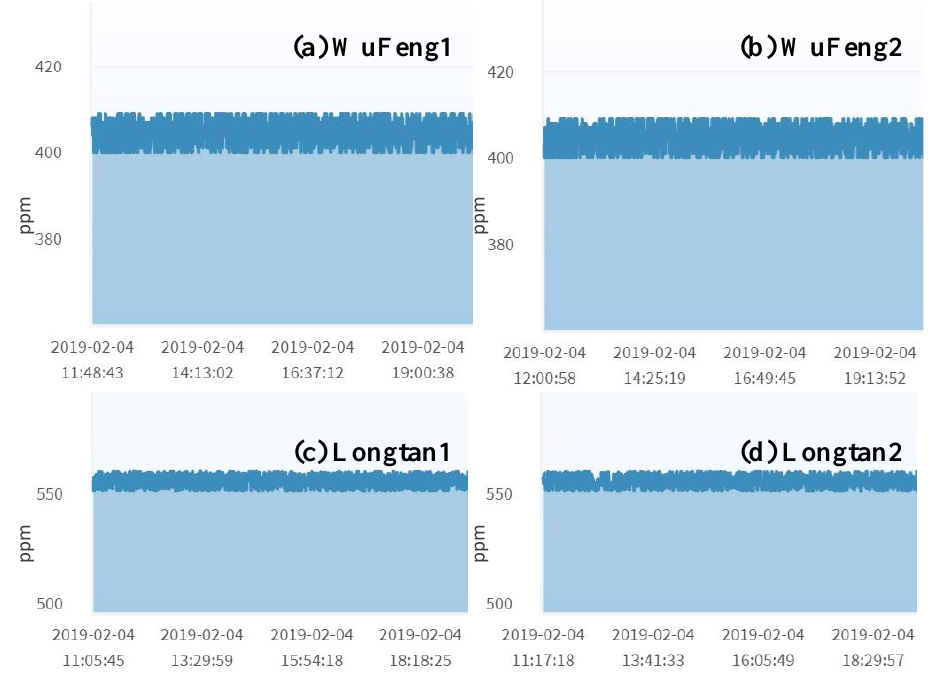
Figure 6. CO 2 concentration.